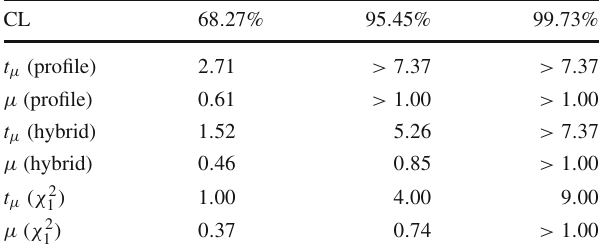
Table 9 Upper bounds on t μ and corresponding μ at different CL for the LHC-like new physics search discussed in Sect. 3, obtained from pseudo-experiment employing a profiled frequentist and hybrid frequentist-Bayesian treatment of nuisance parameters. The last two rows show the asymptotic result obtained with a χ 2 1